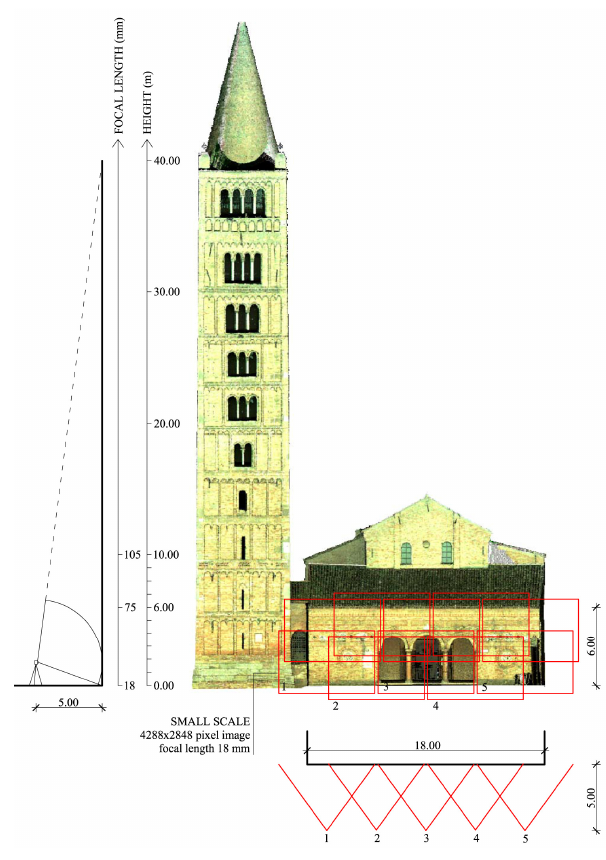
Figure 5. Schema of the close up image-based survey campaign planning using the Nikon D90 camera. In red, photographs related to the small scale (1:20) survey.